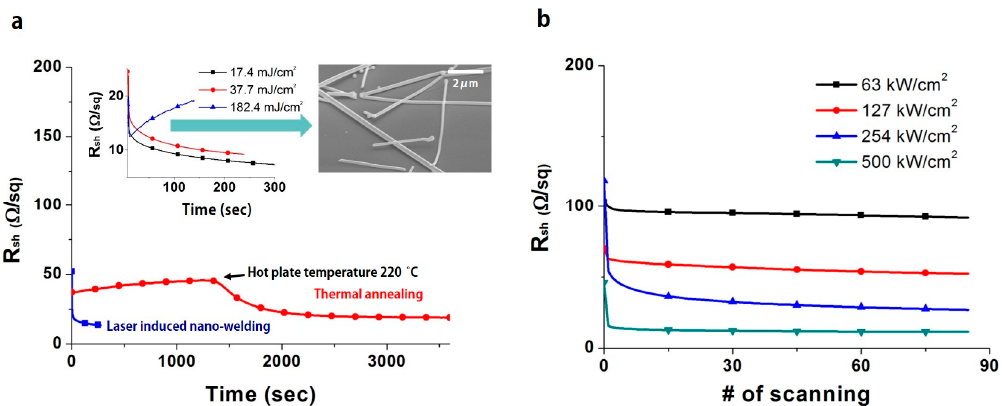
Figure 3. ( a ) Sheet resistance changes at various times in the thermal annealing process and ns pulse laser-induced nano-welding (LINW) process. The inset graph shows a magnified view of the ns pulse LINW process. SEM images show the laser ablation results of Ag NW percolation networks. ( b ) The sheet resistance changes with various numbers of laser scans and various laser power levels in the cw scanning LINW process.